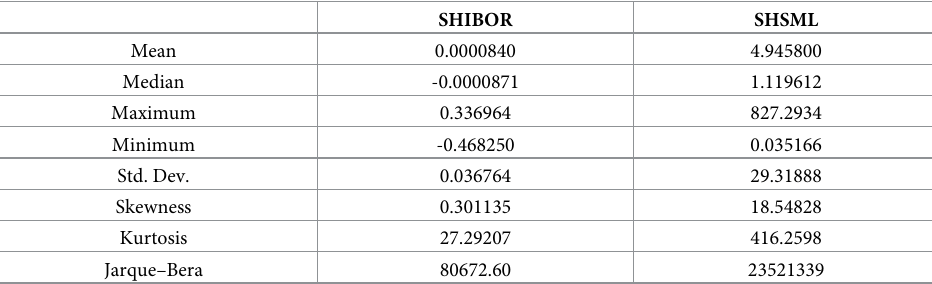
Table 1. Descriptive statistics of SHIBOR and